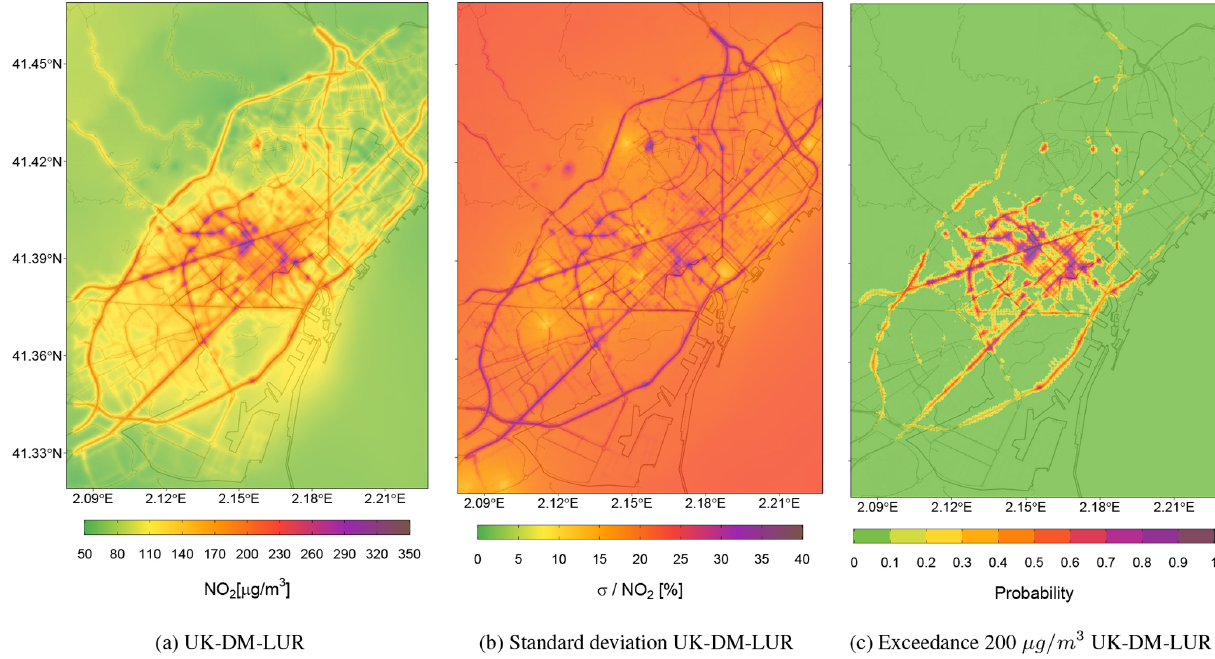
Figure 11. (a) Hourly NO 2 concentration map as a result of applying the UK-DM-LUR methodology at 09:00UTC on 28 February 2019. (b) Relative uncertainty associated with the predictions in panel (a) . (c) Hourly probability map exceeding the 200µgm − 3 NO 2 hourly averaged limit, using the values in panels (a) and (b)